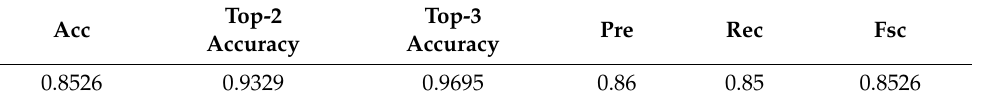
Table 4. Best accuracy after fine-tuning using modified Resnet-50 transfer learning model.